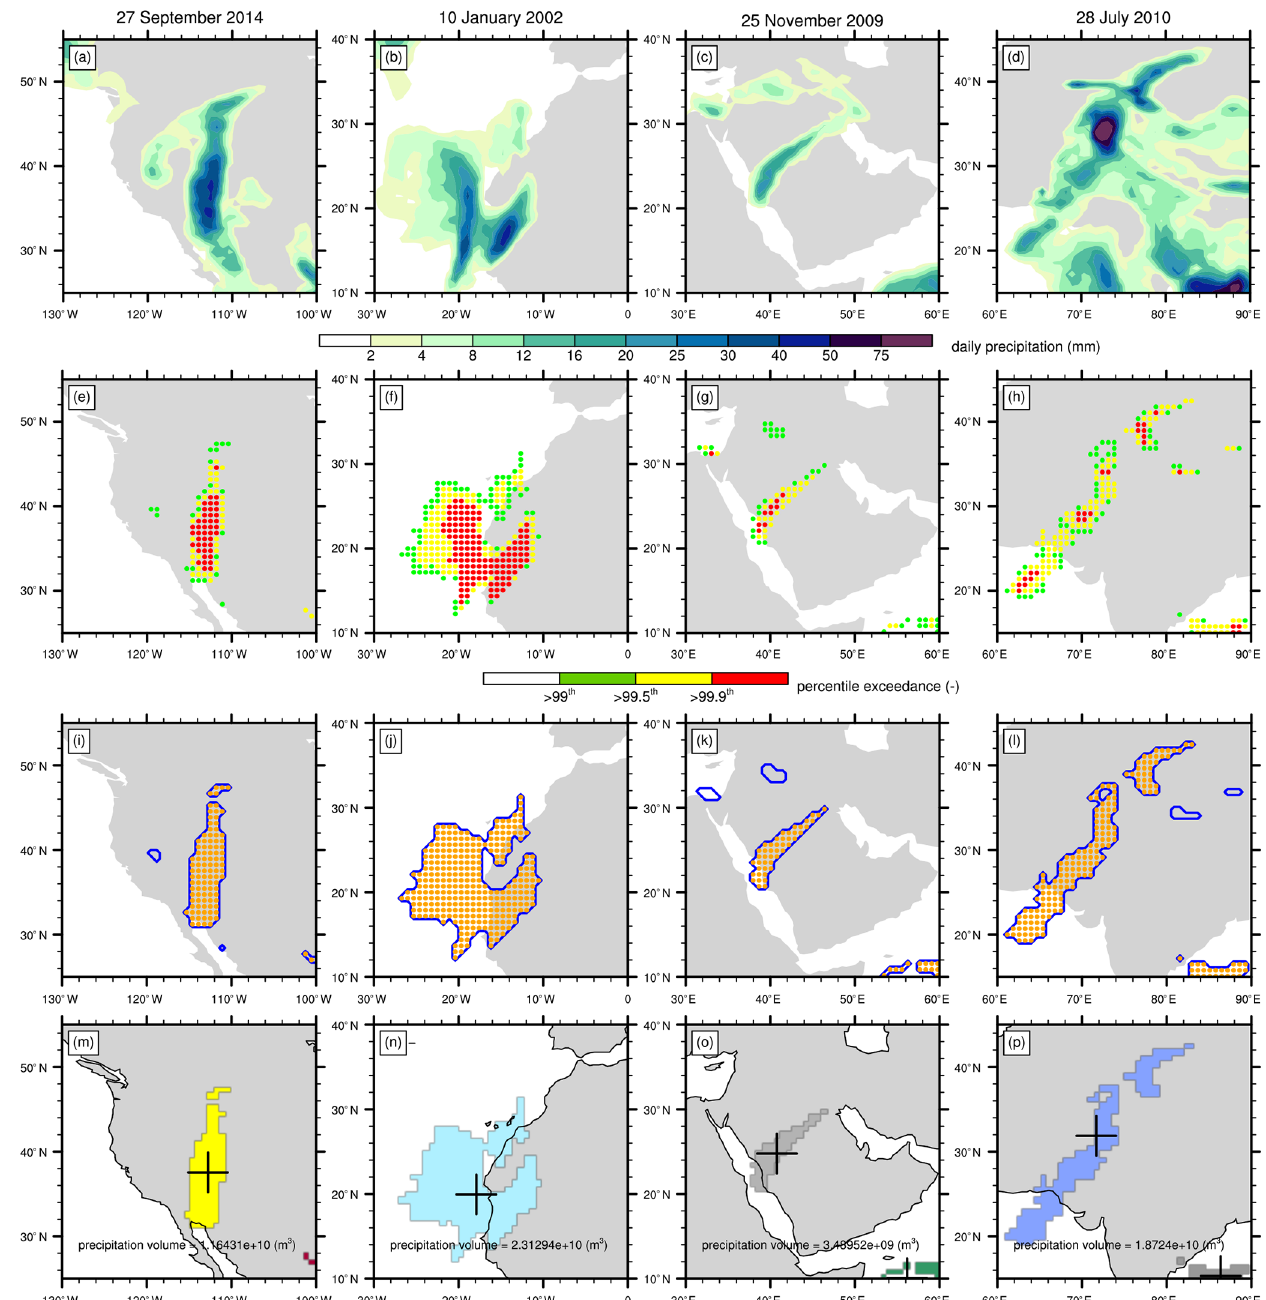
Figure 2. Examples of the algorithm for identification of EPEs for (a, e, i, m) Arizona, USA, 27 September 2014; (b, f, j, n) northwestern Africa, 10 January 2002; (c, g, k, o) Jeddah, Saudi Arabia, 25 November 2009; and (d, h, l, p) Pakistan, 28 July 2010. In (a–d) daily rainfall amounts; (e–h) grid points that exceed the annual 99th (green), 99.5th (yellow), and 99.9th (red) percentiles; (i–l) extreme precipitation objects with a surface > 50000km 2 and consisting of connected grid points within R< 250km; and (m–p) extreme precipitation objects illustrated by random colours, with their mass-weighted centres denoted by the markers, and their volumes (m 3 ) stated in the text.